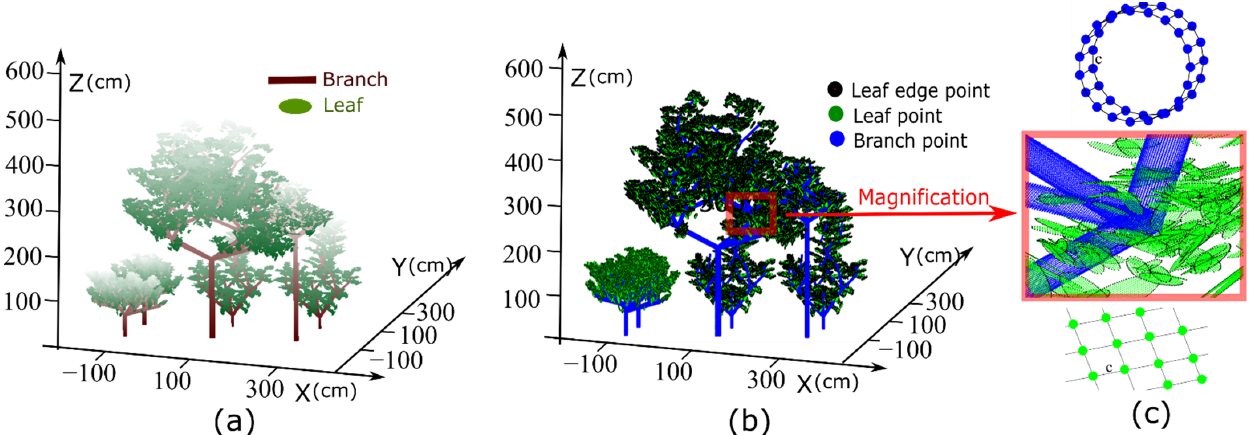
Figure 2. Our program shows the reconstructed forest plot scenario based on the field measurement data. ( a ) The several trees constituting a forest plot for our study, and the brightness value is adopted to represent the height value. ( b ) The discretization of tree models using evenly distributed sampling points covering the vegetative element surfaces, where the blue, green, and black points represent the sampling points on the branch surface, leaf surface, and leaf edge, respectively. ( c ) The magnification of simulated tree crotch structure, where the spot spacing between two neighboring discrete points used in uniform sampling strategy is set to c . Table 1. Growth properties of the available tree specimens used in our simulation method. Some growth properties, including height, crown diameter, number of leaves, and total leaf area of the tree crown, were manually collected by field measurements [24], and other properties were derived from the manually collected properties mentioned